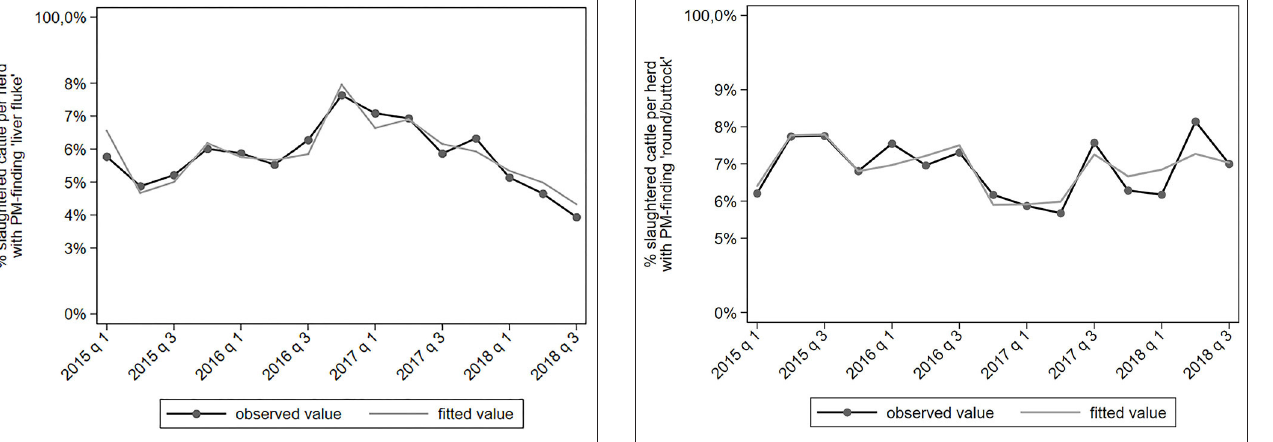
FIGURE 6 | Observed and predicted percentage of slaughtered cattle per dairy herd with a PM-finding categorized under “liver fluke,” per quarter between January 2015 to September 2018 ( N = 78,366).